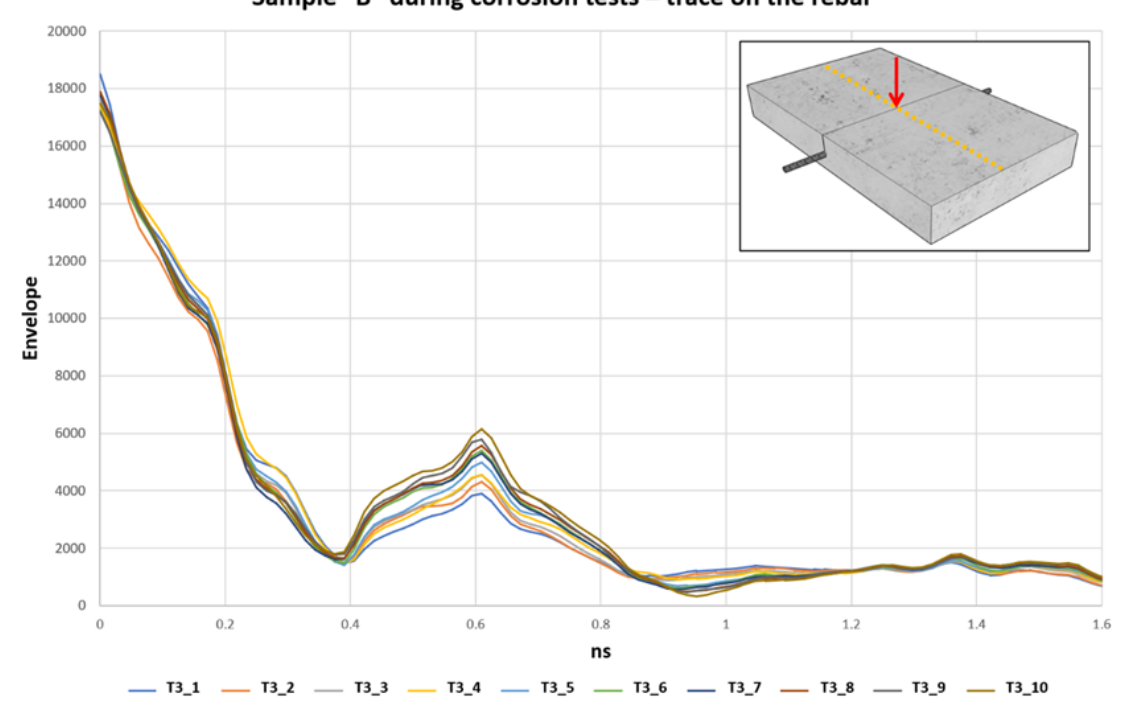
Figure 10. Envelope A-scan was acquired on sample “B” during the accelerated corrosion test. The trace shown is taken from radargram 29, which is exactly in the middle of the concrete sample. The track considered is above the steel rebar present at 0.6 ns.